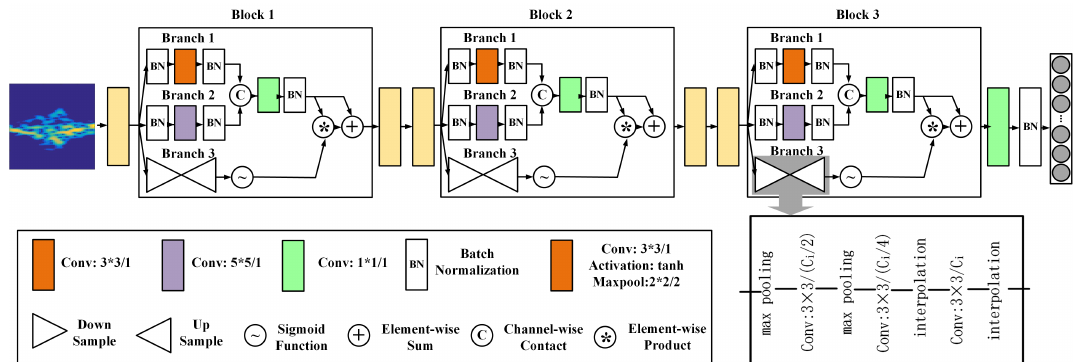
Figure 2. The feature extractor part of MRA-Net , which is composed of three blocks. There are three branches in each block: coarse-scale learning branch, fine-scale learning branch and residual attention learning branch. All branches are able to facilitate the feature learning process. In the CNN-based feature extractor, the convolution operation with a kernel size of 3 × 3 and a stride of 1 is denoted as 3 × 3/1, and the pooling operation is denoted as the same way.